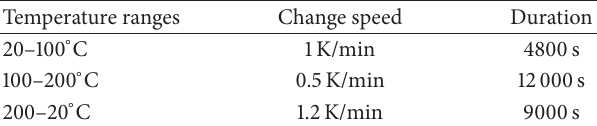
Table 2: Conditions and duration of the microcalorimetric